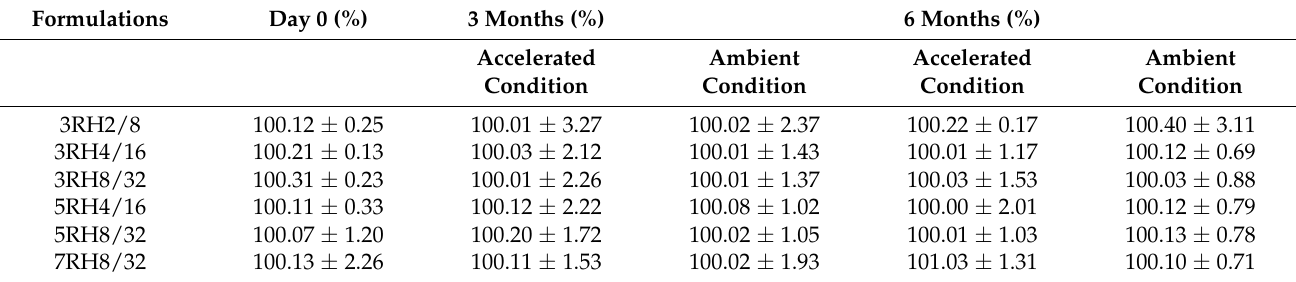
Figure S4: Powder X-ray diffraction patterns of 5RH4/16, 5RH8/32, and 7RH8/32 after storage